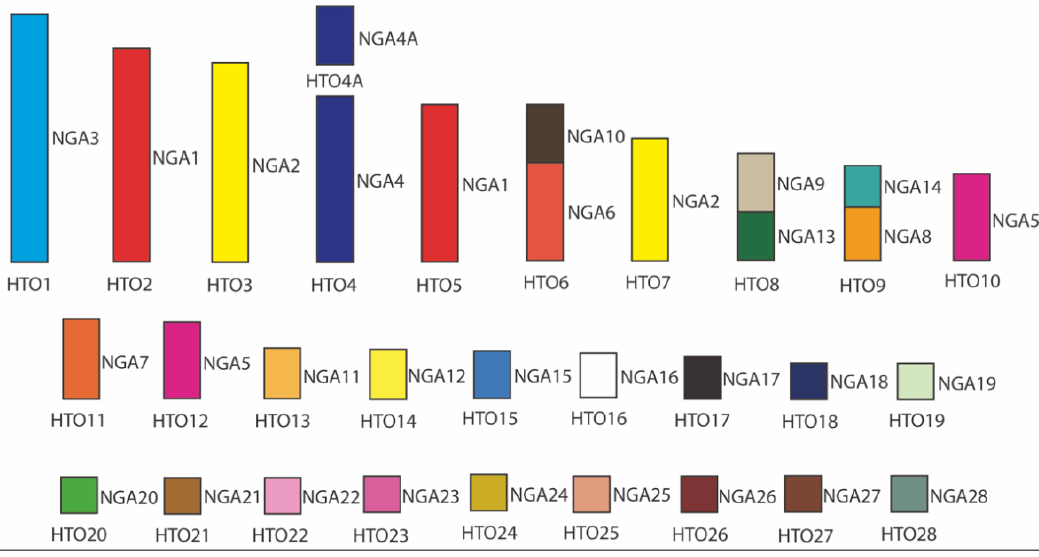
Figure 7. Homology map between Hydropsalis torquata (HTO) and the Neognathae ancestral karyotype (NGA). NGA homologies are represented with a different color. The white color indicates the probable homology with NGA16.